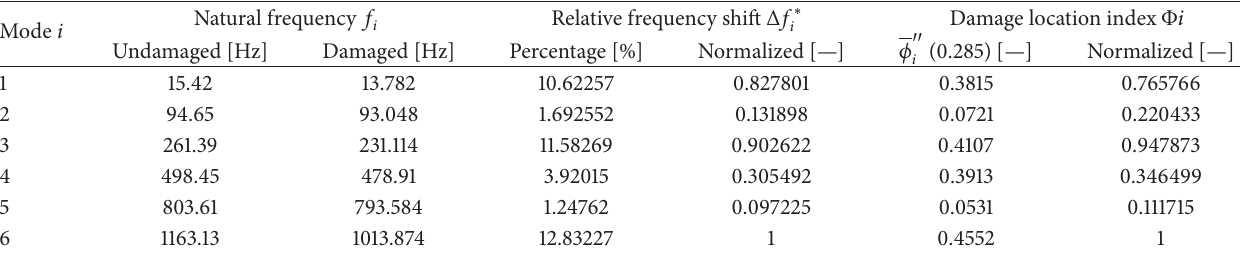
Table 1: Measured natural frequencies and corresponding shifts for the analyzed